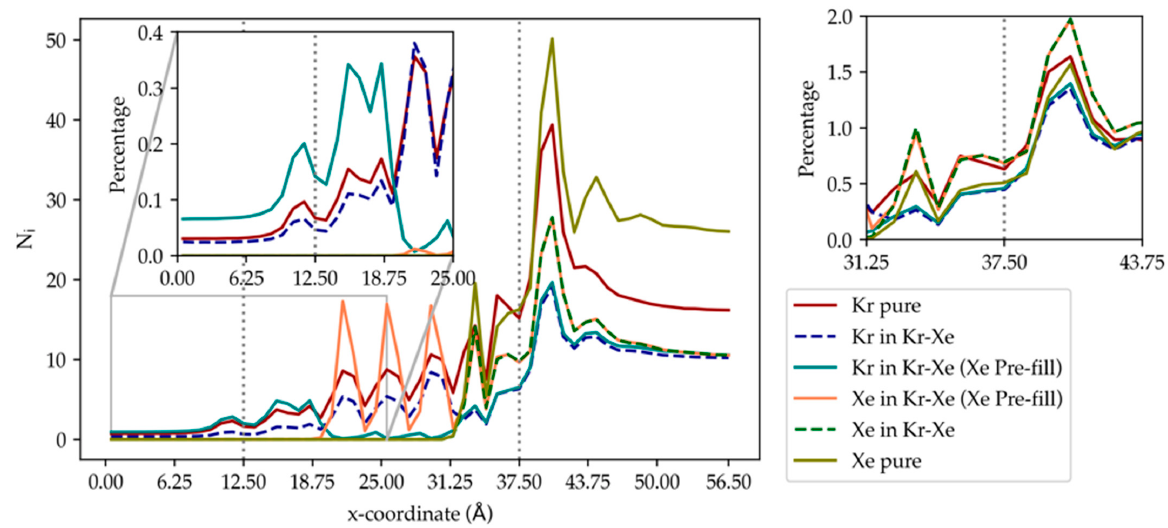
Figure 12. The density profile of Kr and Xe along the direction normal to the membrane surface at two pressures, using results from simulation (2), (5), (7), and (8) at 300 K. The dashed vertical lines correspond to the membrane edges.